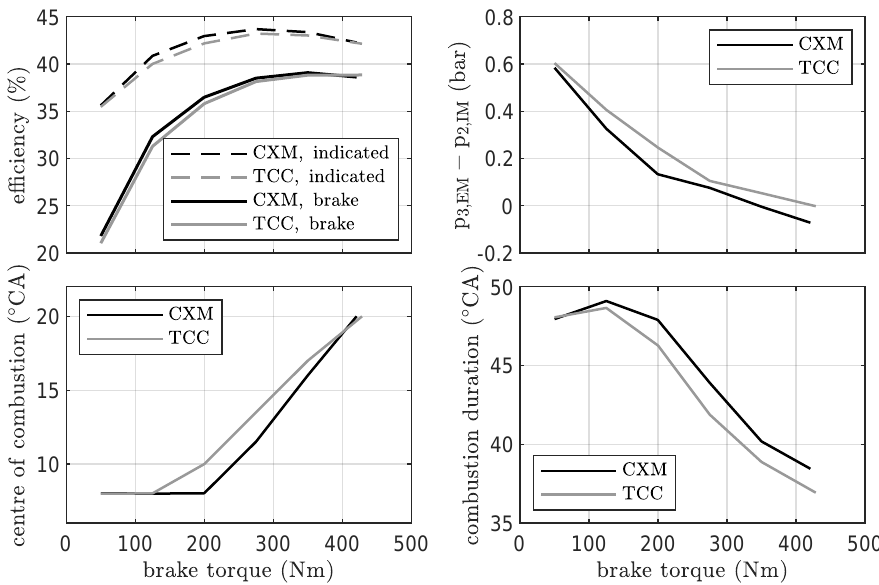
Figure 12. Part-load results of efficiency, gas exchange and combustion for an engine speed of 2200 rpm. The highest load point was measured at 2250